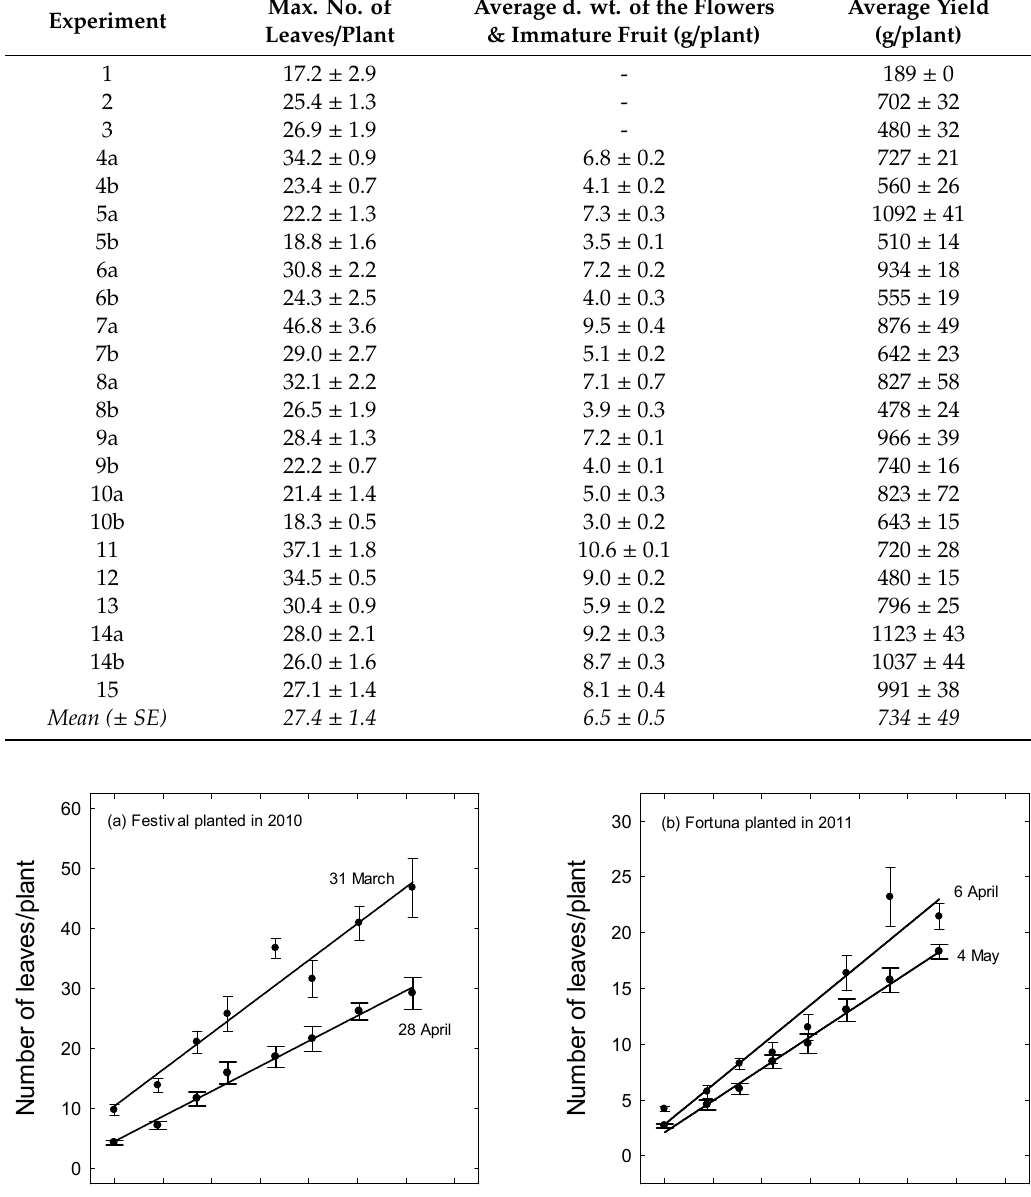
Table 4. Mean maximum number of leaves, average dry weight of the flowers and immature fruit, and yield in the different experiments with the strawberries in Queensland. Data are presented with standard errors (SEs). Details of the experiments are provided in Tables 1 and 2.